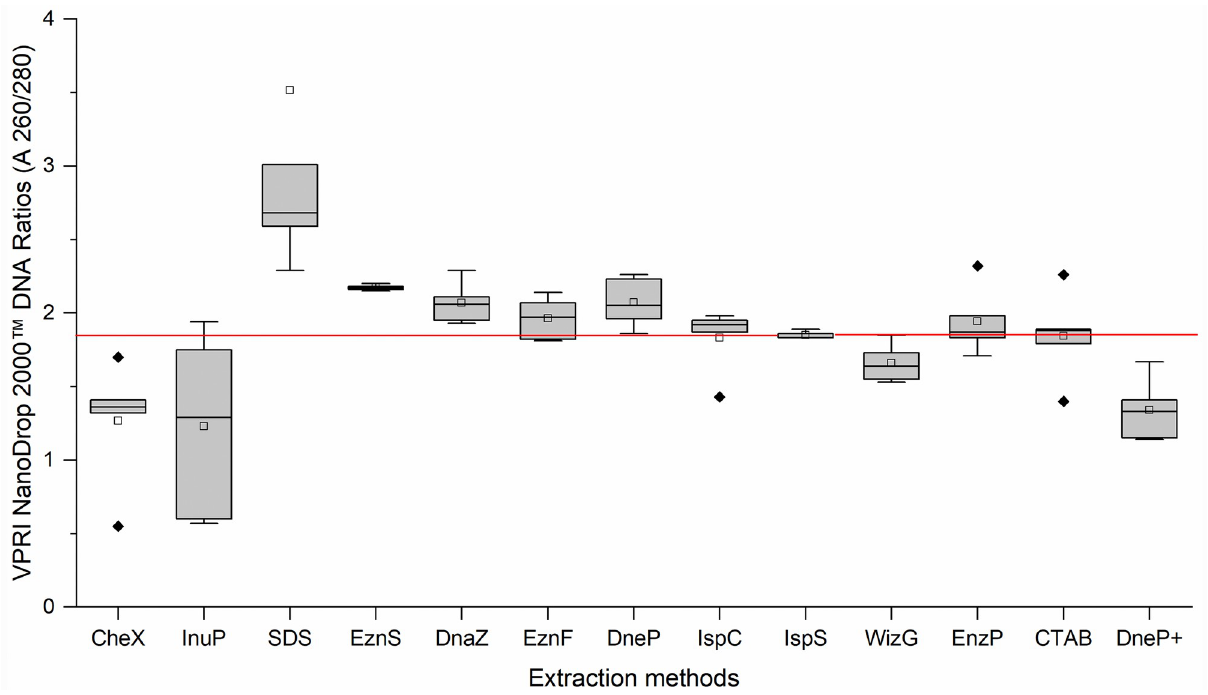
Fig 3. Boxplots of the DNA quality measured by thermo scientific nanodrop 2000 ™ absorbency measurement 260 nm / 280 nm ratios of five victorian plant pathology herbarium (VPRI) apple powdery mildew specimens produced by 13 DNA extraction methods. The red line indicates the desired target absorbency ratio 1.8–1.9. Median line __ ; Mean □ ; Outlier Extraction method abbreviations: Chelex 1 100 (CheX), innuPrep Plant DNA (InuP), sodium dodecyl sulphate (SDS), E.Z.N.A. 1 SP Plant (EznS), DNAzol ™ (DnaZ), E.Z.N.A. 1 Forensic DNA (EznF), Qiagen DNeasy 1 Plant (DneP), Isolate II Plant DNA Lysis buffer PA1 C (IspC), Isolate II Plant DNA Lysis buffer PA2 S (IspS), Wizard 1 Genomic DNA Purification (WizG), E.Z.N.A. 1 Plant (EznP), Cetyl trimethyl ammonium bromide (CTAB) and Qiagen DNeasy 1 Plant plus PTB (DneP+).